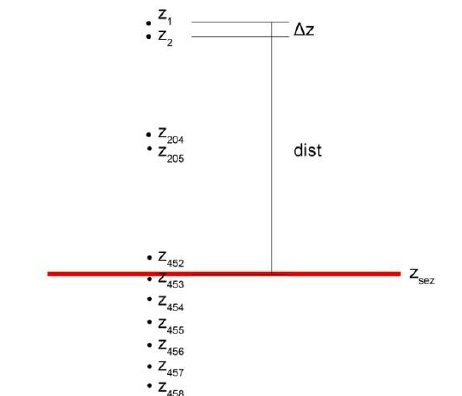
Figure 6. Raw data sequential processing and skipped points